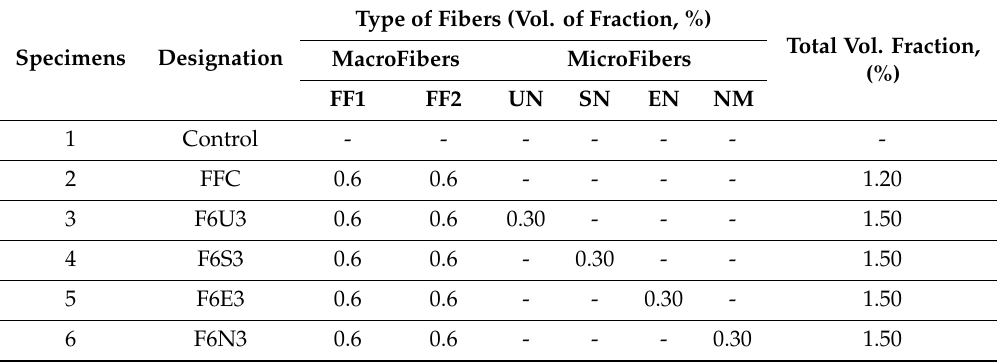
Table 2. Selected Hybrid Fiber Reinforced Concrete (HyFRC) for constitutive modeling. (C: